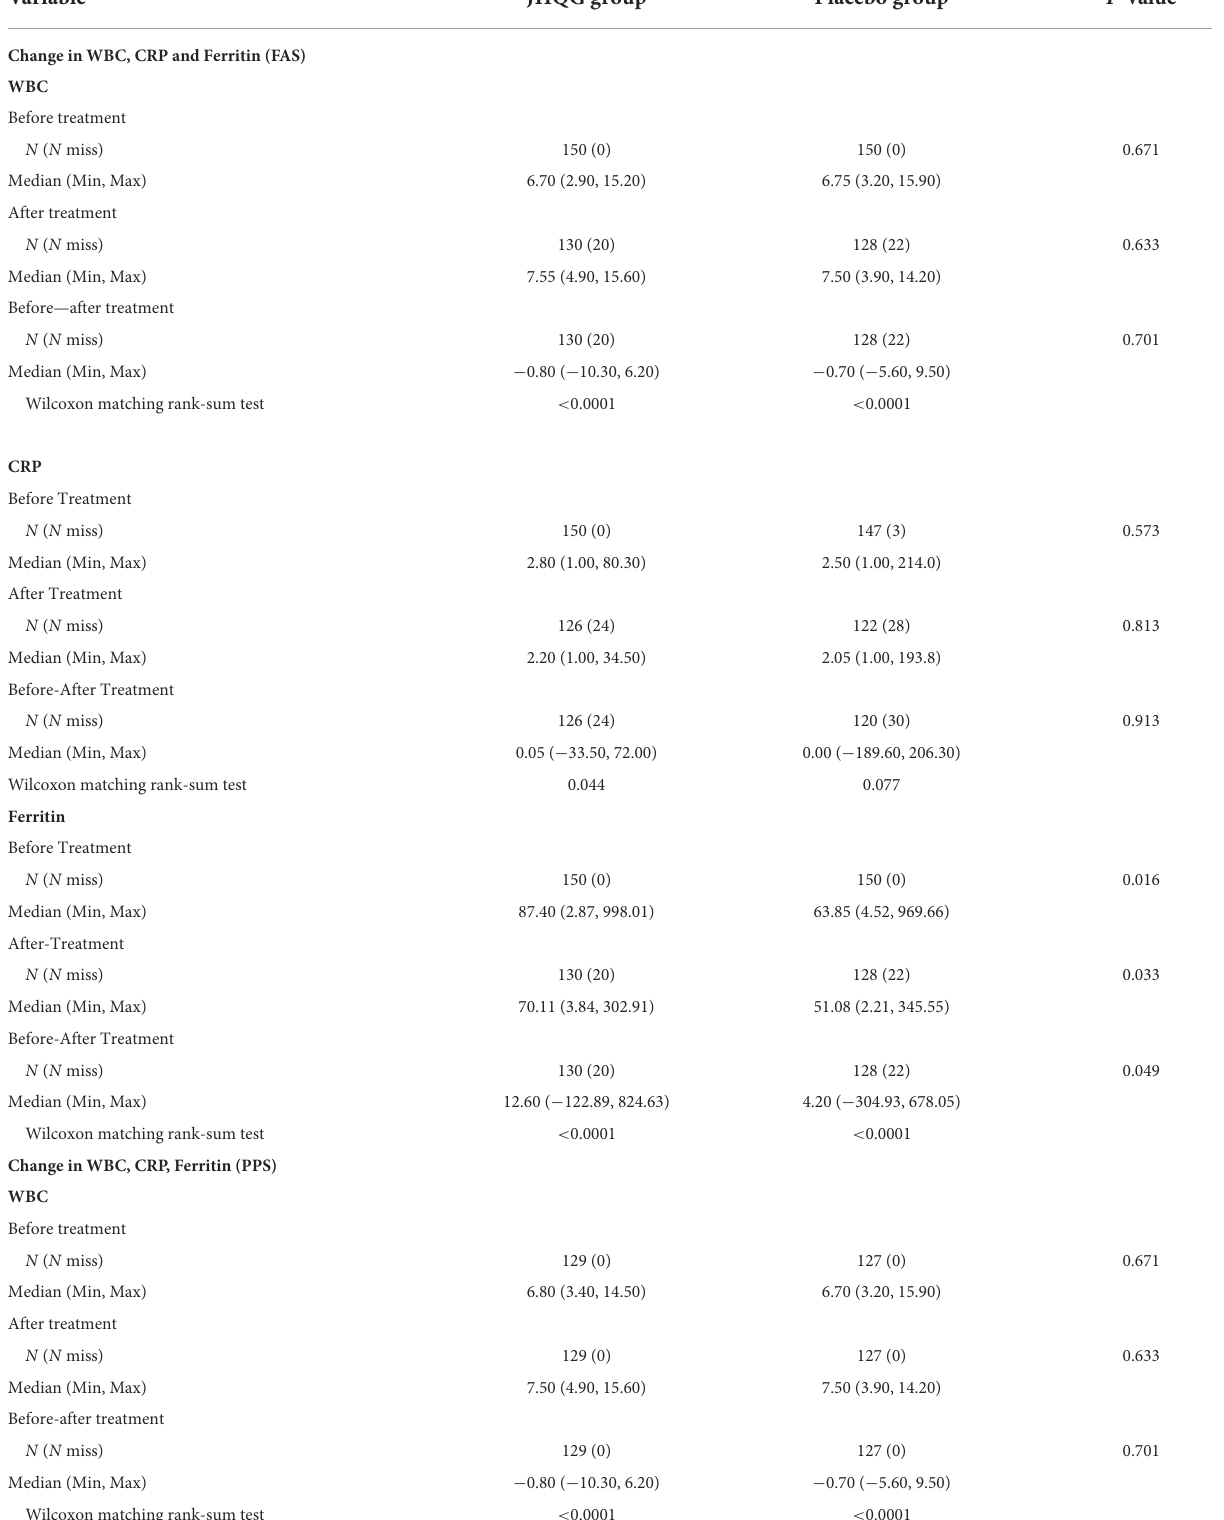
TABLE 10 Change in WBC, CRP, and Ferritin (FAS/PPS). Variable JHQG group Placebo group P